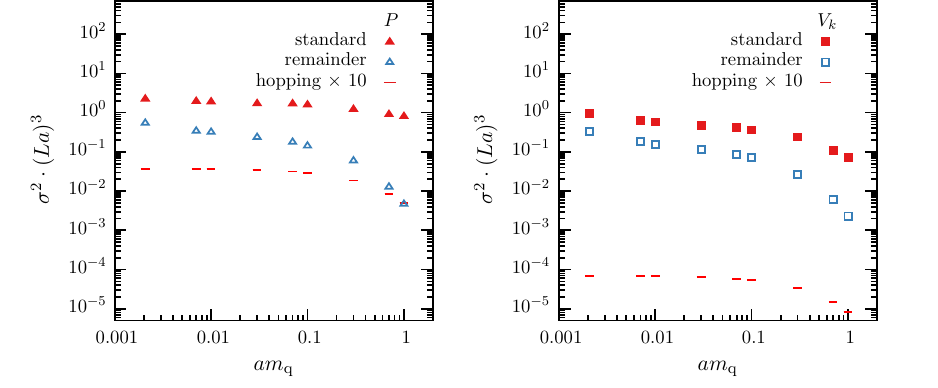
Fig. 3 Variances for N s = 1 of the random-noise estimators τ R (remainder, open blue symbols) for the pseudoscalar density (left) and the vector current (right) as a function of the bare quark mass am q for